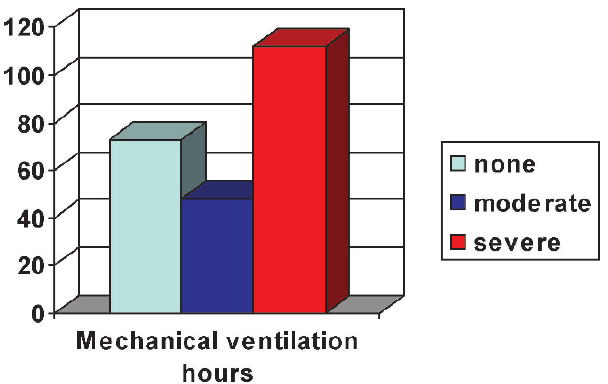
Figure 4 - Total amount of mechanical ventilation in hours distributed according to patient-prosthesis